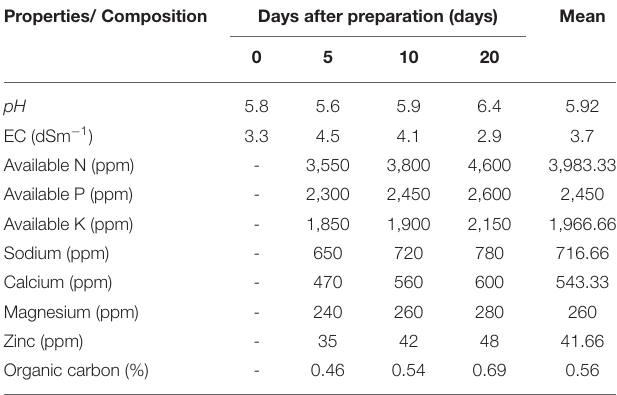
TABLE 1 | Chemical properties of panchagavya